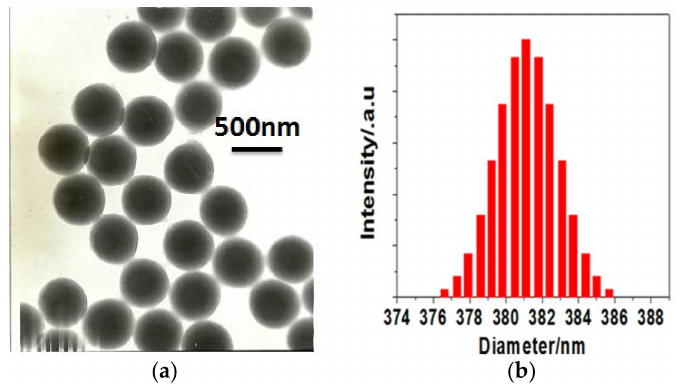
Figure 1. ( a ) TEM images and ( b ) size distributions of polymer spheres.